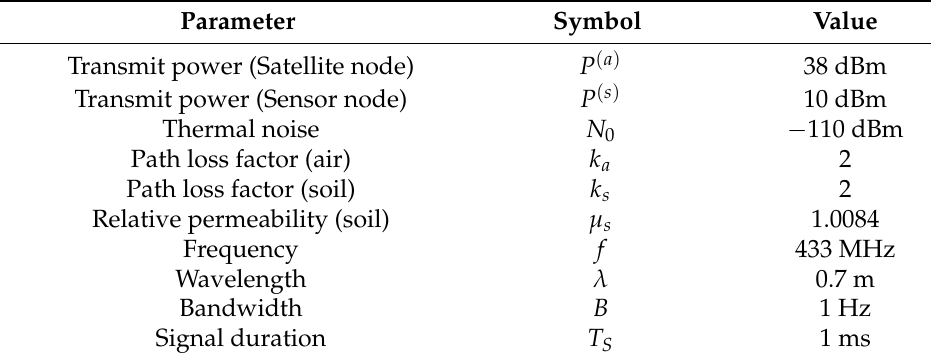
Table 2. Parameters used in the simulations for localization.